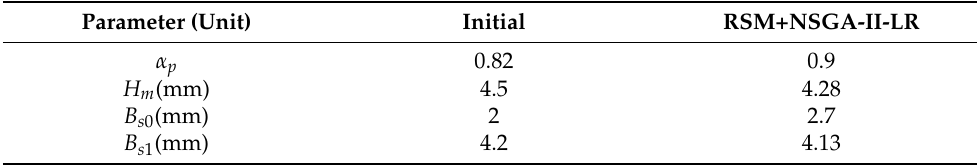
Table 6. Parameters before and after SPMSM